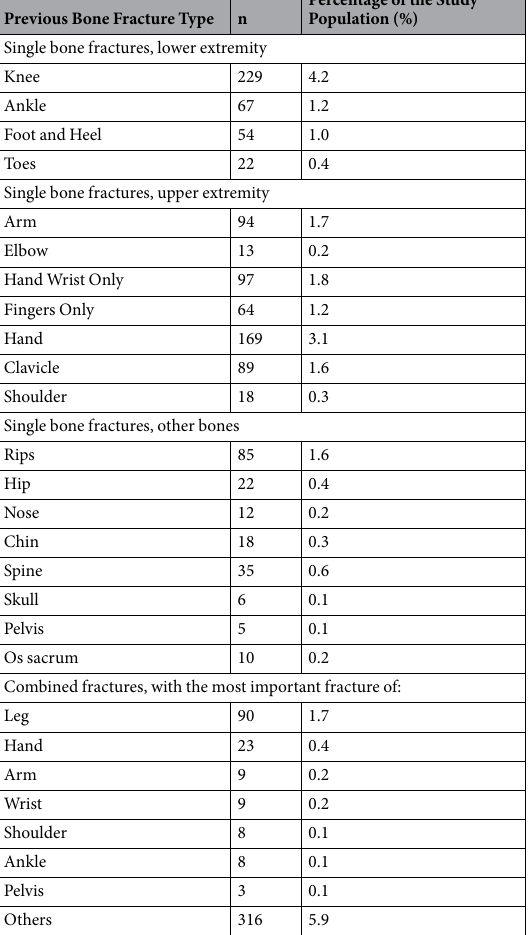
Table 2. Frequency (%) of previous bone fractures in the Ural Eye and Medical Study, stratified by fracture location.